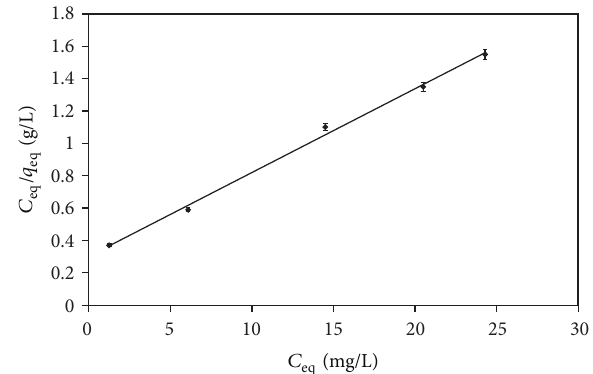
Figure 7: Langmuir biosorption isotherm for lead at 0.1g in 30mL of biosorbent concentration and solution pH of 6.0.